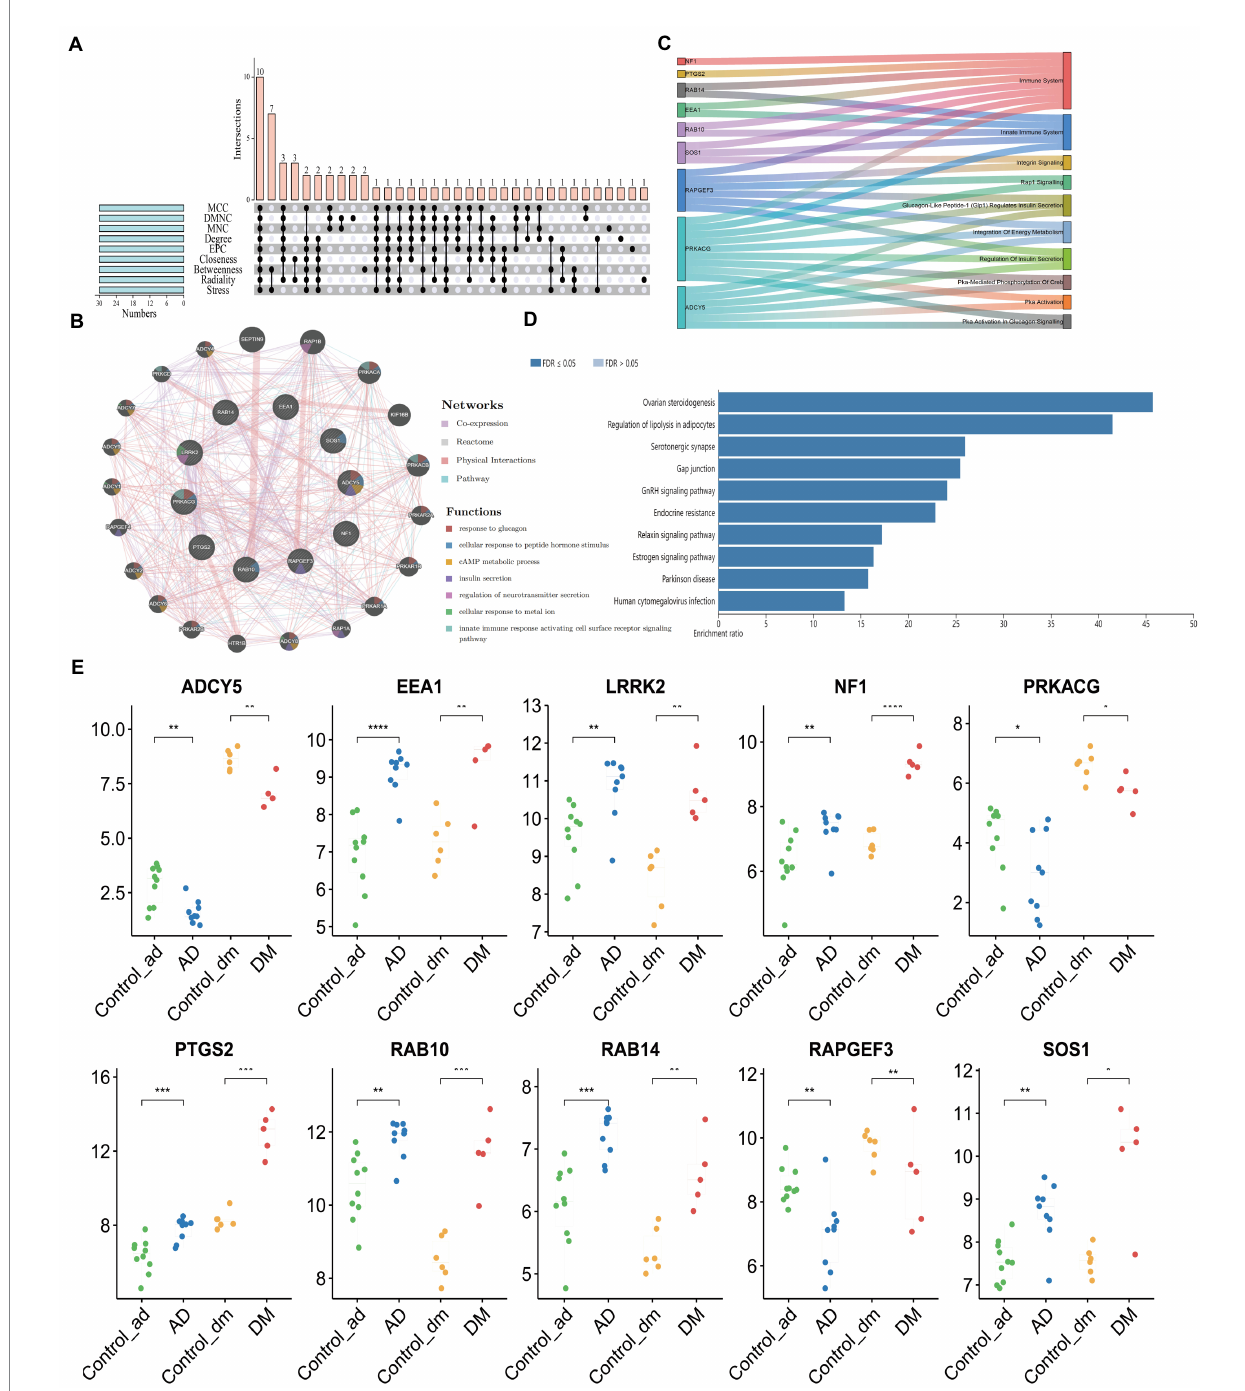
FIGURE 7 Acquisition of Hub Gene and Analysis of Co-expression Network. (A) The Venn diagram showed that nine algorithms have screened out 10 overlapping hub genes, (B) Ten hub genes and their co-expression network were analyzed by GeneMANIA, (C) Functional distribution of Hub gene, (D) Pathway analysis with WebGestalt, and (E) The mRNA expression of 10 Hub genes. Unpaired t -test, Mean ± SD, p -value <0.05 was considered significant, * p <0.05, ** p <0.01, *** p <0.001.